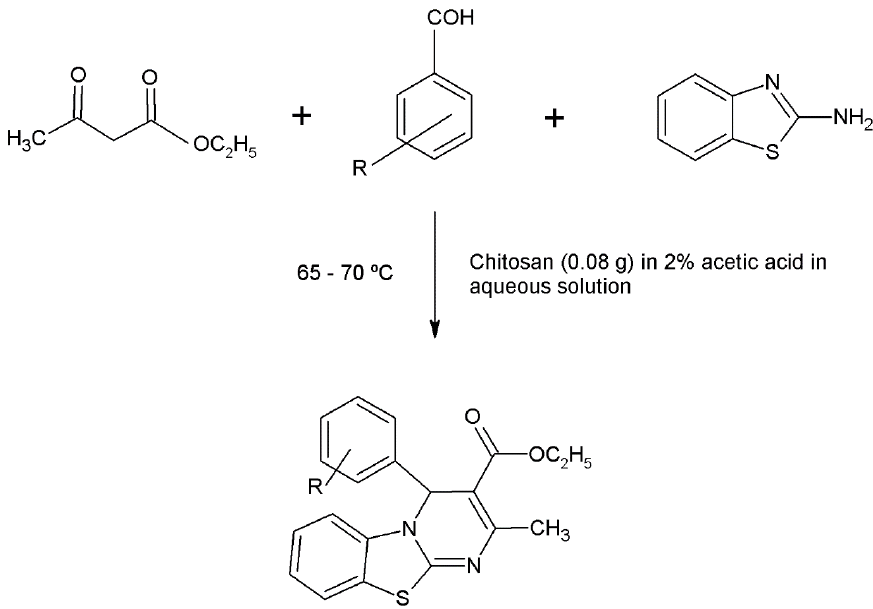
Figure 13. Preparation of 4 H -pyrimido [2,1-b] benzothiazole derivatives.